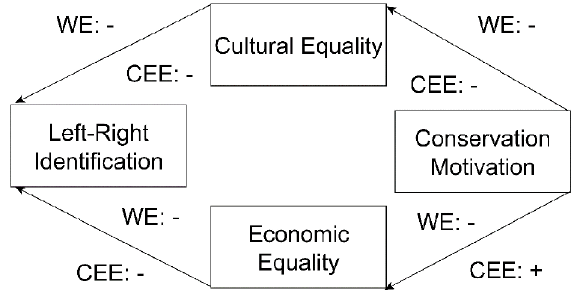
Figure 1. Hypothesized relationships. Note. WE = Western Europe; CEE = Central Eastern